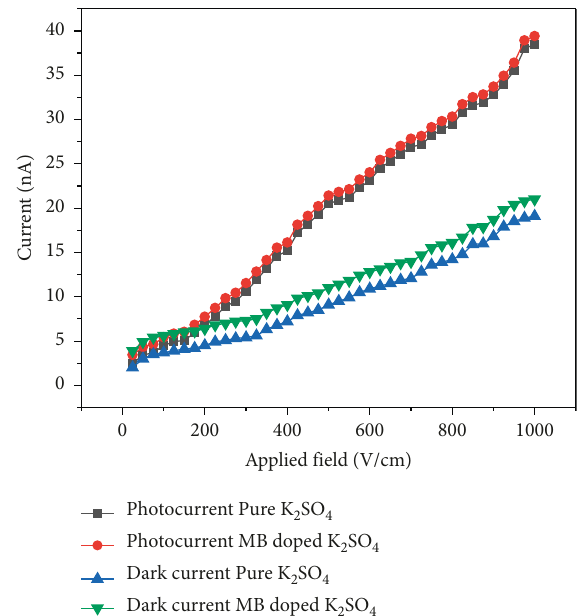
Figure 8: Photoconductivity of the methyl orange dye-doped K 2 SO 4 single crystal.